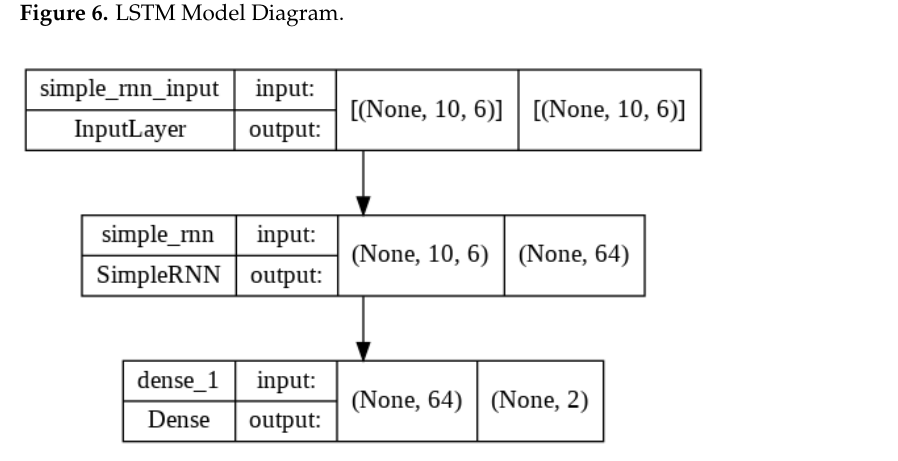
Figure 6. LSTM Model Diagram.